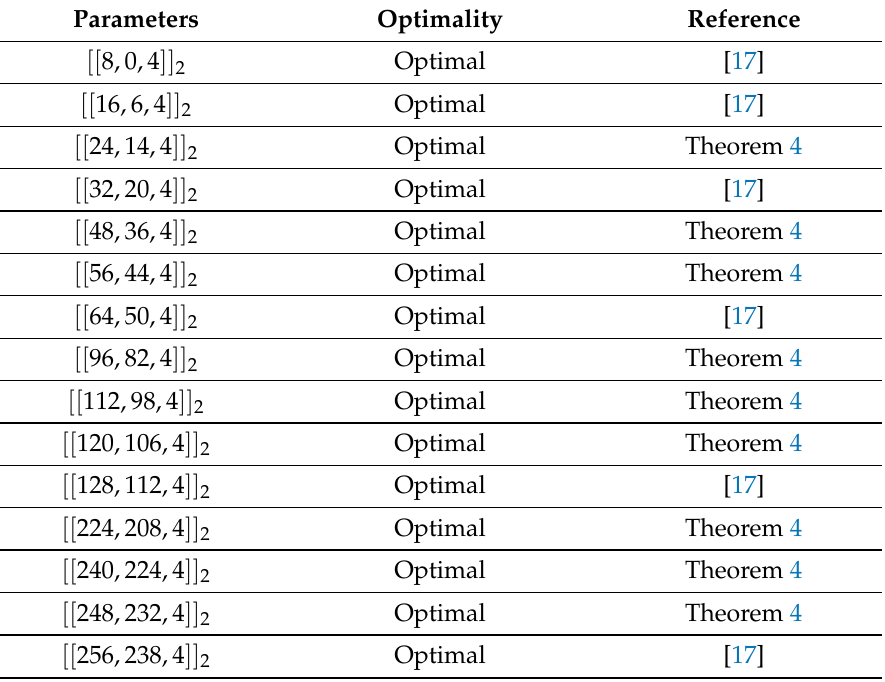
Table 6. Binary quantum codes with minimum distance four from Theorem